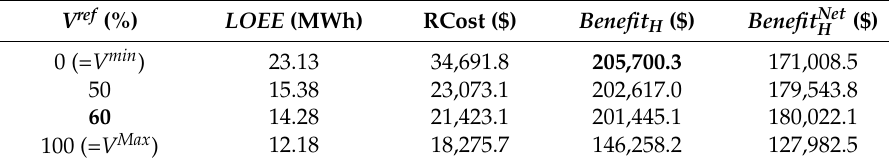
Figure 17. ELCC Evaluation Result. Table 3. Detailed Result of Figure Table 4. Load carrying capability ( ELCC) Evaluation Results.